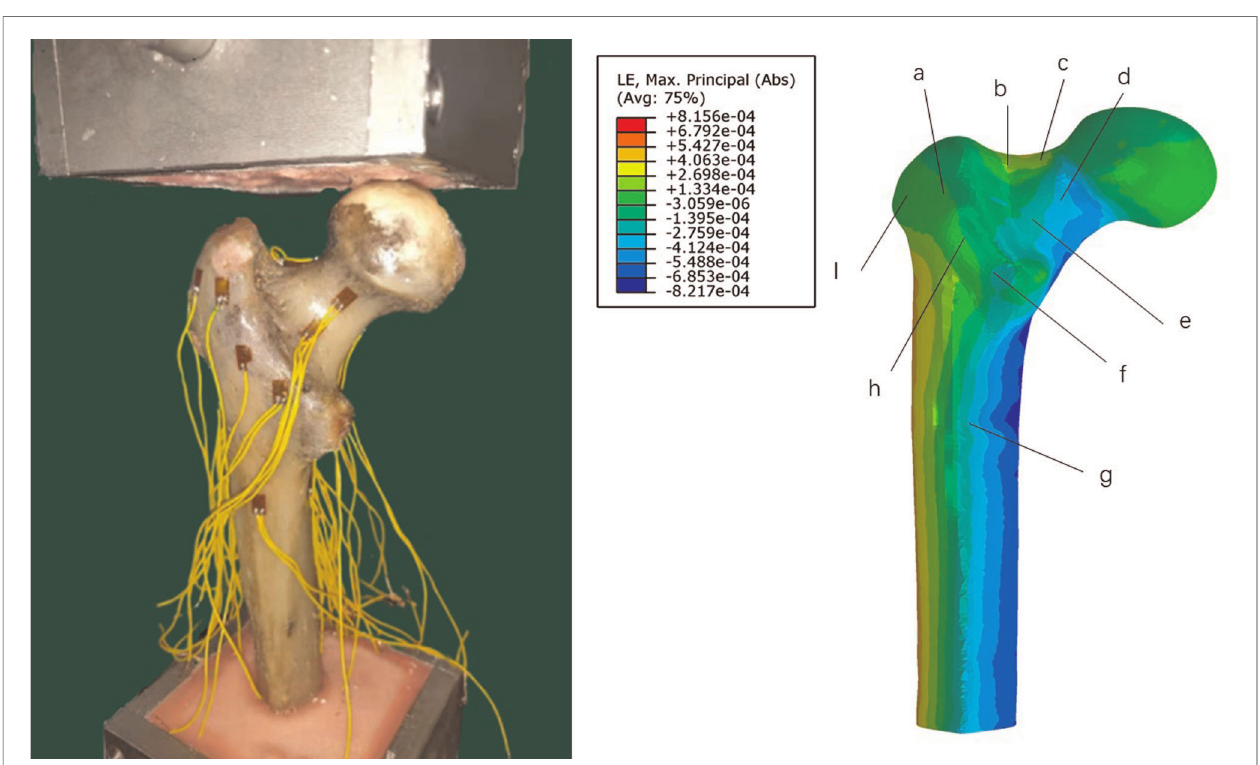
FIGURE 4 | The von Mises stress on the cancellous and cortical bone of the proximal femur was tested to analyze the mesh convergence and validate the model.